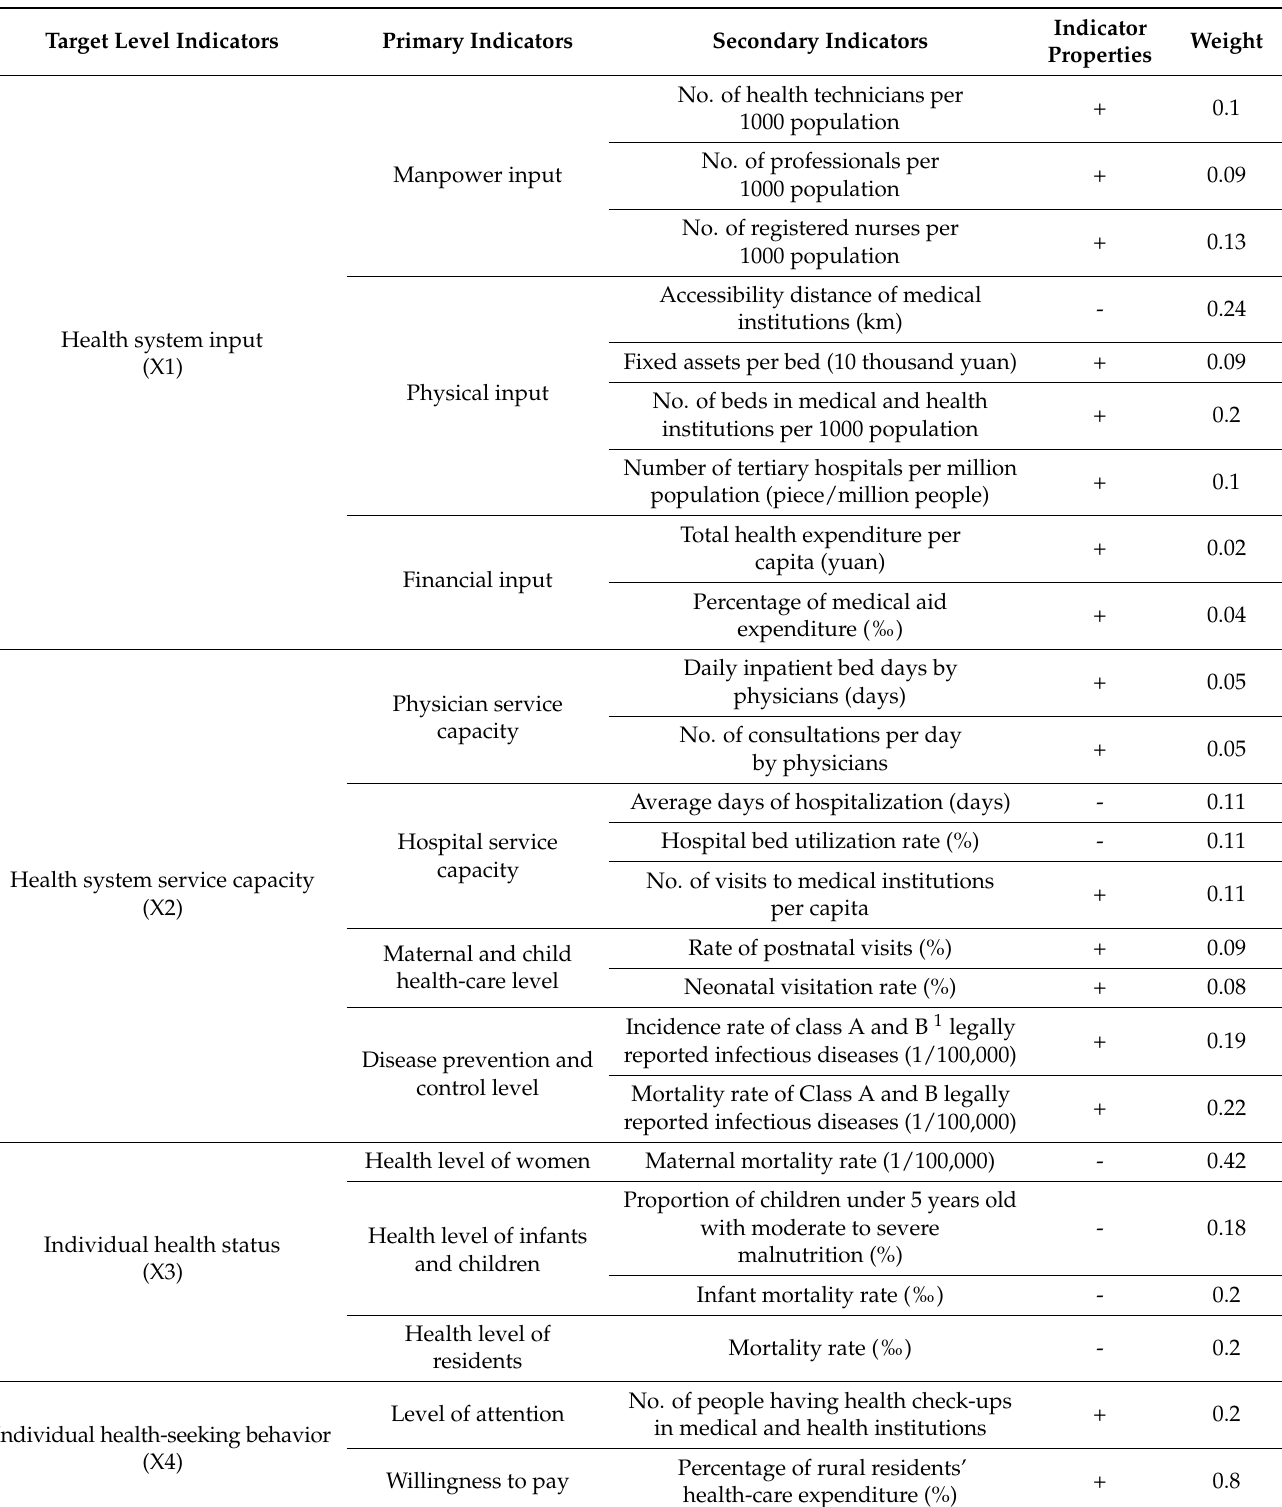
Table 1. Indicators for measuring multidimensional health